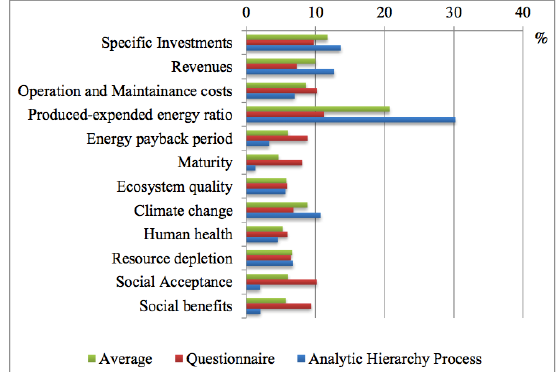
Fig. 4. Criteria weight values from Analytic Hierarchy Process methodology, expert questionnaires and the final